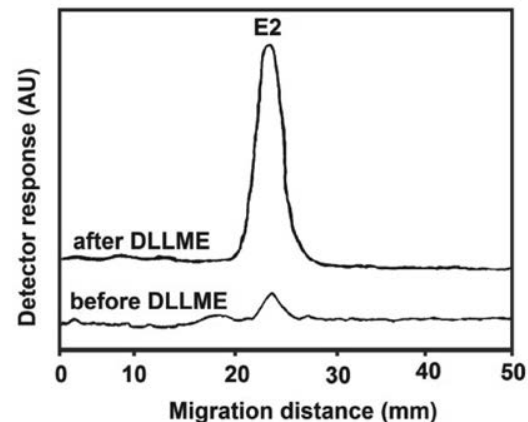
Figure 3. Chromatogram of model urine sample spiked at 0.1 mg mL –1 with estradiol (E2) before and after DLLME.